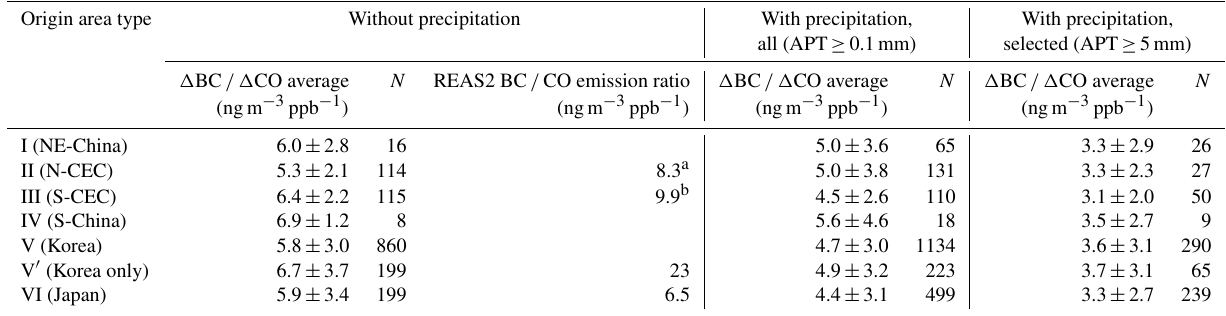
Table 2. (cid:49) BC /(cid:49) CO ratios (average and 1 σ range) for individual origin area types with and without precipitation. REAS2-derived emission ratios are included for comparison.